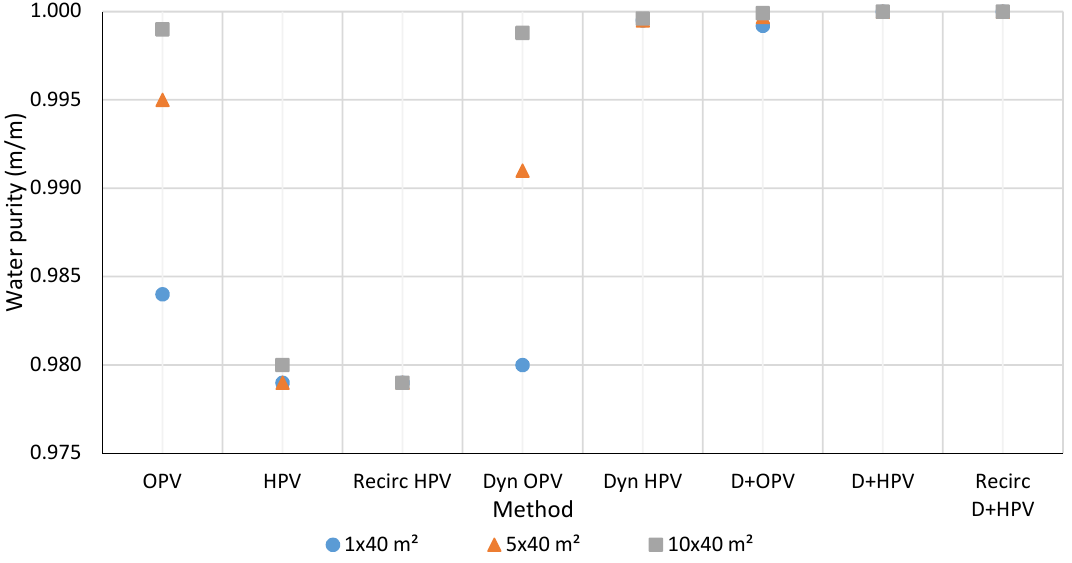
Figure 12. Comparison of the ethanol purity of ethanol-water purification methods.